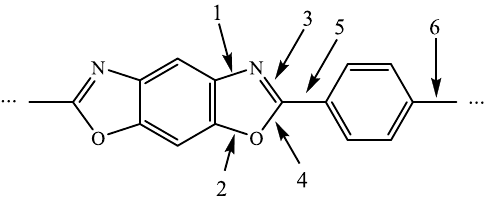
Figure 3. A monomer part of the PBO polymer chain.